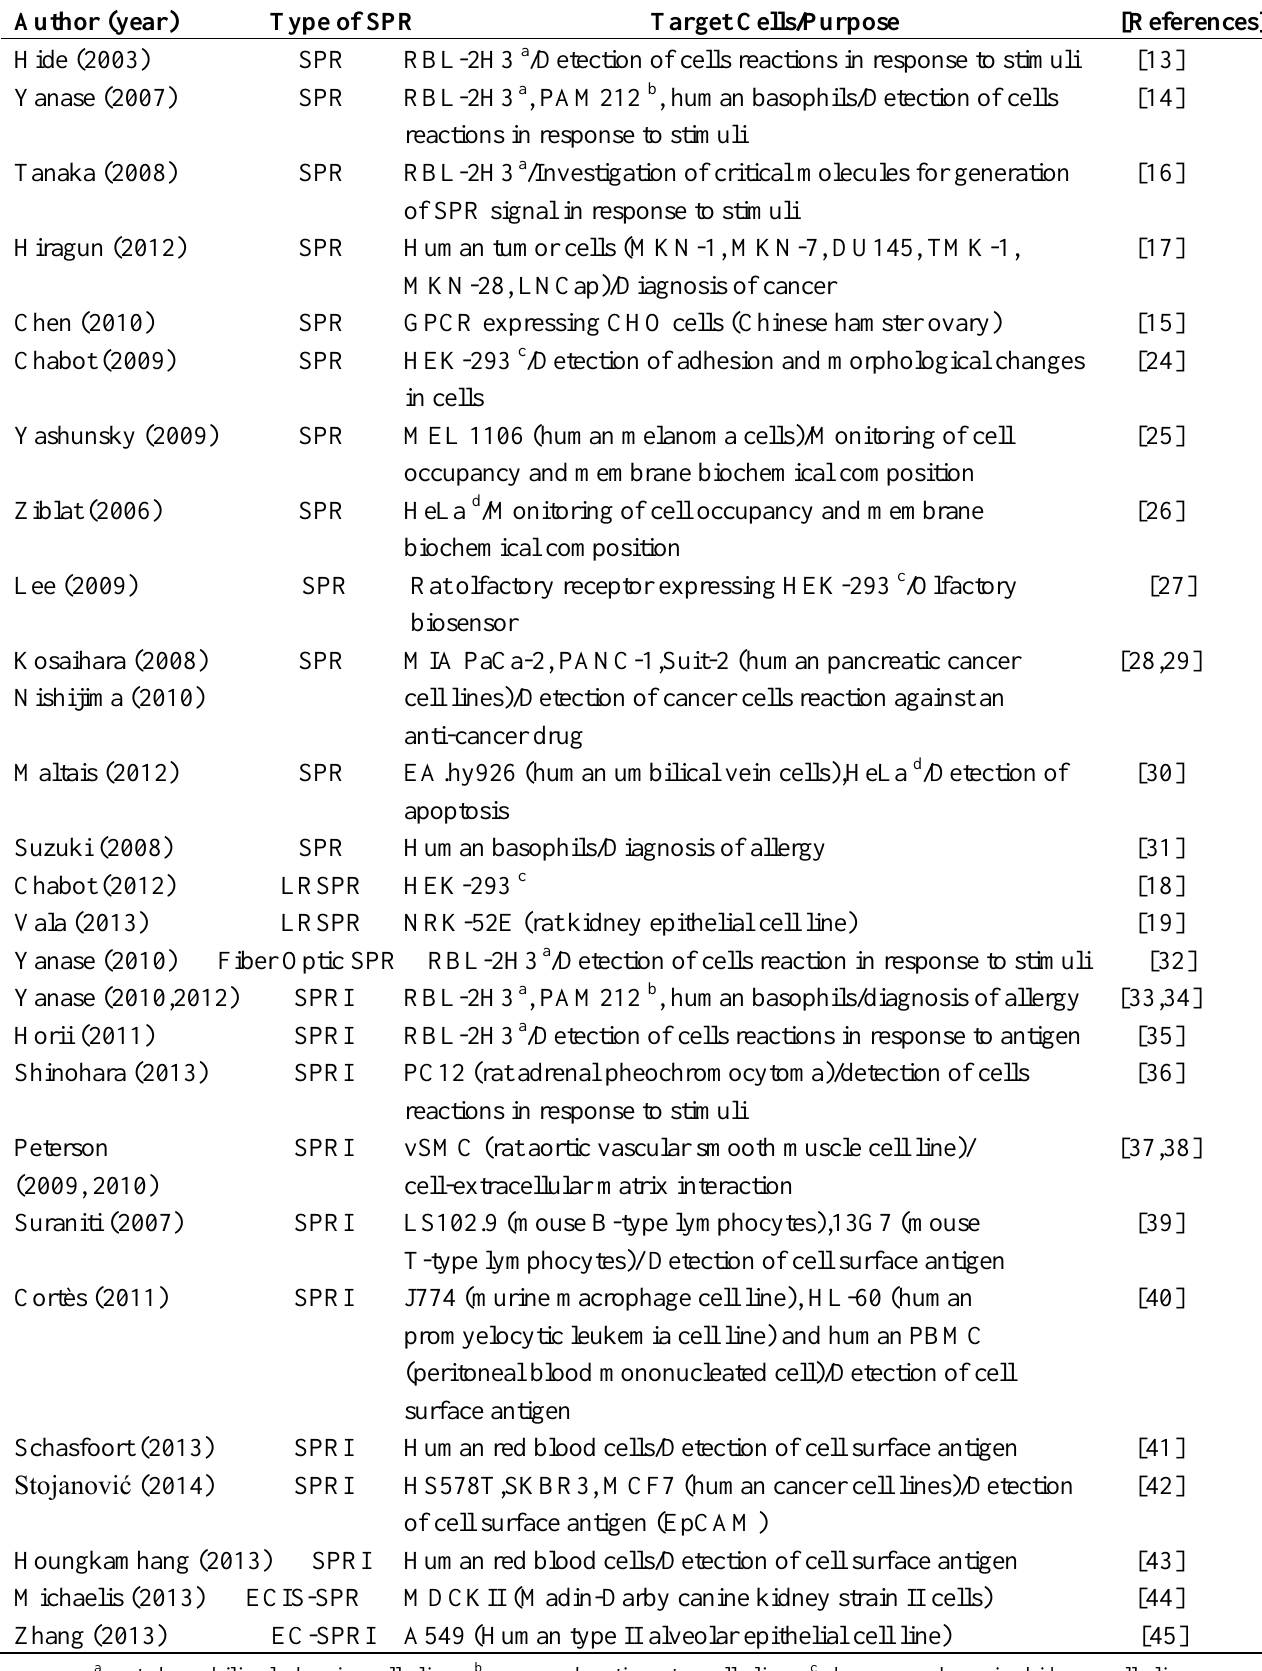
Table 2. Living cell analysis by means of